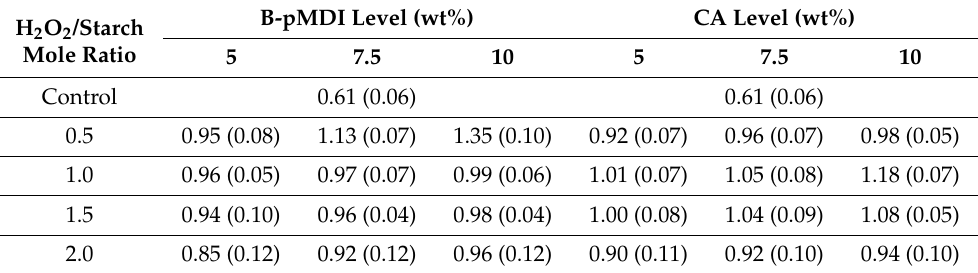
Table 3. Tensile shear strength (MPa) of plywood bonded with OS adhesive at different H 2 O 2 /starch mole ratios, contents, and cross-linkers